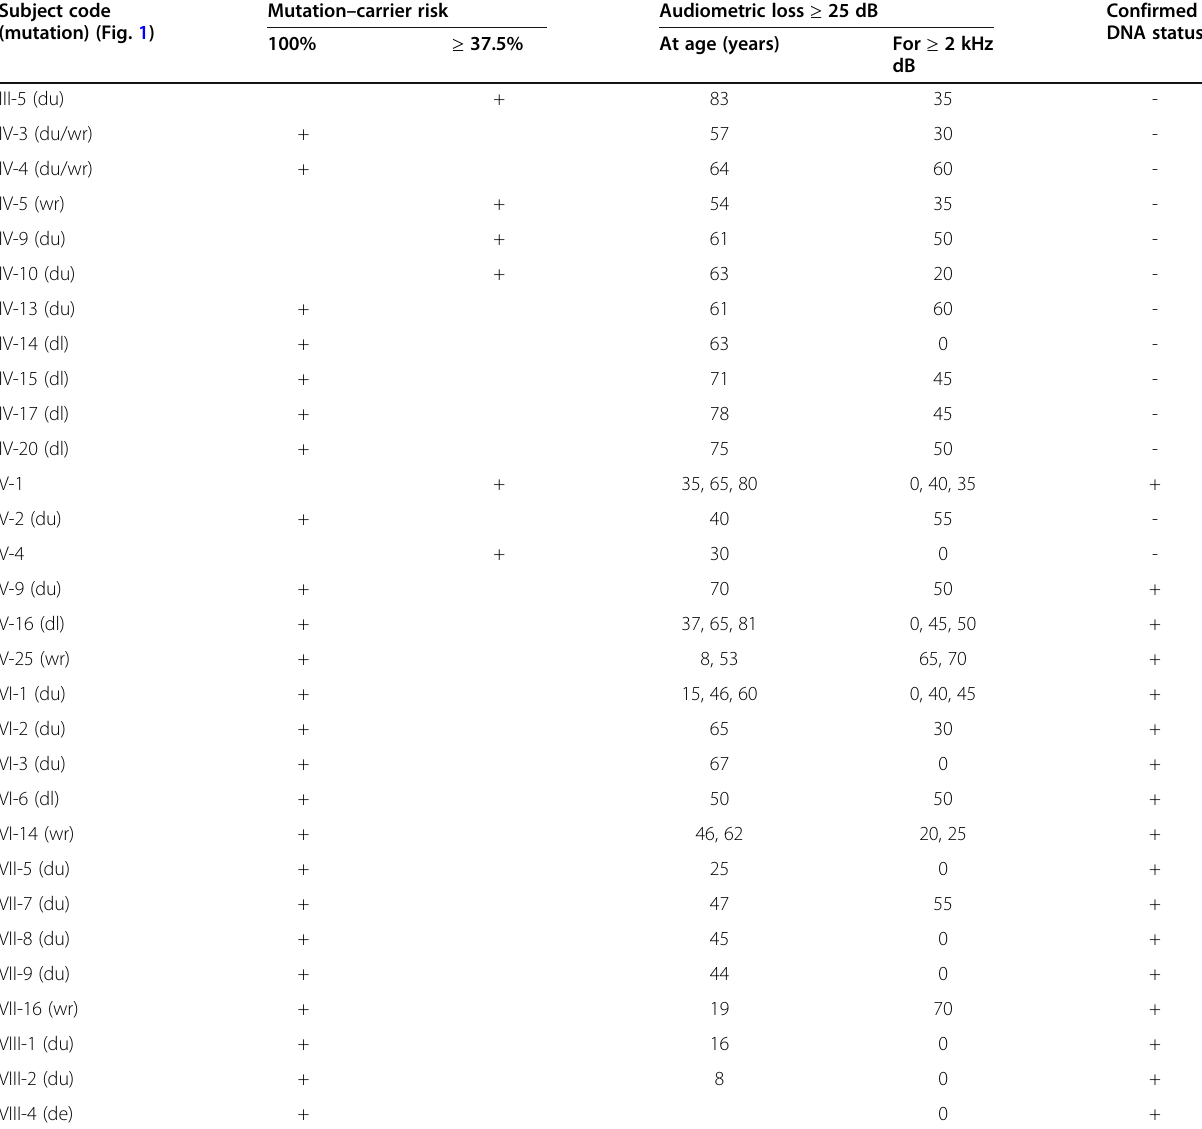
Table 2 Audiometric phenotype (air) in obligate heterozygotes and in those with an a priori c.35dupG (du), p.W77R (wr), c.35delG (dl) mutation carrier risk ≥ 37.5% [(25 + 50%)/2] Subject code (mutation) (Fig.